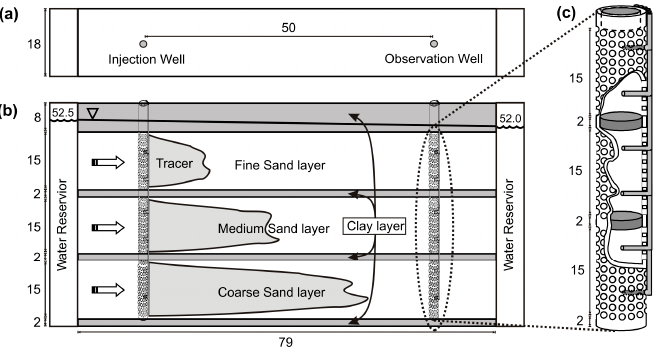
Figure 2. Setup of tank experiment: ( a ) Plan view; ( b ) Cross-section; ( c ) Well description (units in cm).